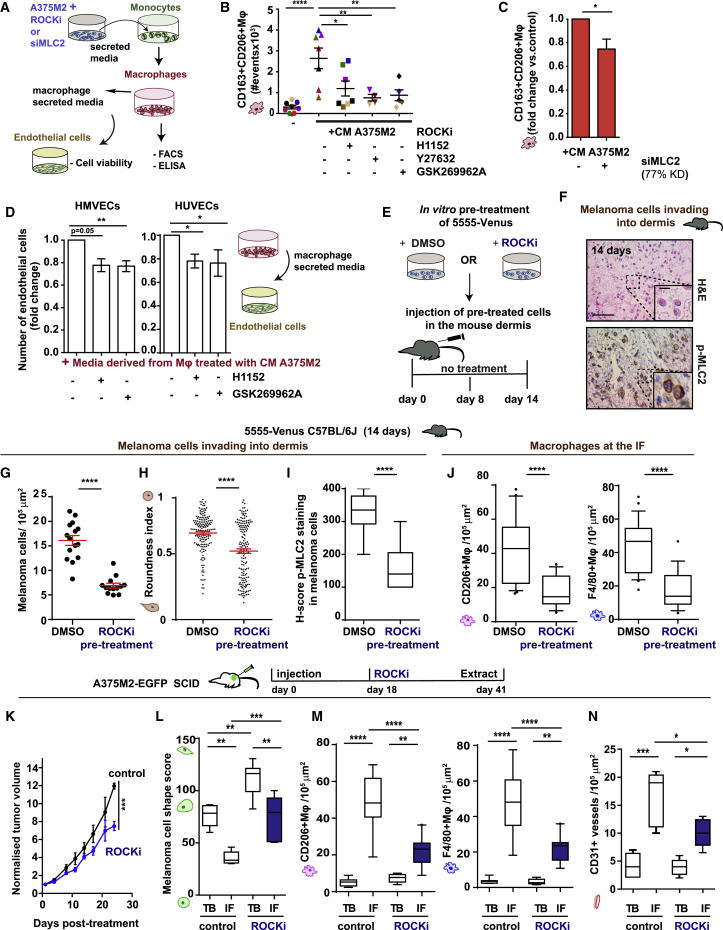
Blocking Myosin II Activity in Melanoma Cells Reprograms Macrophages(A) Schematic: in vitro treatment of PBMC-derived monocytes with CM from ROCK inhibited or MLC2 depleted A375M2 cells and subsequent assays.(B) CD163+CD206+ macrophages after treatment of PBMC-derived monocytes with CM A375M2, CM A375M2+ROCKi, or media only (–) (n = 8;8 different healthy donors; each dot is a different donor).(C) PBMC-derived monocytes treated with CM A375M2 depleted from MLC2 and quantification of CD163+CD206+ macrophages. Data are presented as fold changes versus control (n = 4).(D) Quantification of fold change of absorbance (O.D.): viability of endothelial cells (HMVECs and HUVECs) after treatment with macrophage-derived supernatants (50%). Media were derived from monocytes ± CM A375M2+ROCKi (n ≥ 3 for HMVECs and n = 6 for HUVECs). Endothelial cells were treated with macrophage-derived supernatants for 72 h.(E) Schematic: in vivo experiment with GSK269962A ROCKi pre-treated 5555 cells.(F) Representative H&E image (top) and IHC image for p-MLC2 showing amoeboid melanoma cells with high p-MLC2 invading the dermis in the IF of tumors 14 days post-intradermal injection of DMSO (vehicle) pre-treated 5555 cells. Scale bar, 50 μm; insert, 10 μm.(G–I) Number of invading melanoma cells (G), roundness index (H), and H-score (I) for p-MLC2 for (G).(J) (Left) CD206+ and (right) F4/80+ macrophages in the IF.(G–J) Tumors from DMSO (vehicle) pre-treated or ROCKi-pretreated Venus-5555 cells 14 days post-intradermal injection (n = 14 control and n = 12 ROCKi).(K) Tumor volume of A375M2 xenografts treated with PBS or Y27632 ROCKi.(L–N) Melanoma cell-shape score (L) and quantification (M) of (left) CD206+ and (right) F4/80+ and (N) CD31+ cells, in A375M2 xenografts treated with PBS or Y27632 ROCKi (n ≥ 4).In (B)–(D), (G), (H), and (K), graphs and dot blots show mean ± SEM. In (I), (J), and (L)–(N), boxplots show 10–90 percentile. In (B) and (L)–(N), one-way ANOVA with Tukey post hoc test is shown. In (C) and (G)–(J), t test is shown. In (D), Kruskal-Wallis test followed by Dunn’s multiple comparisons test is shown. In (K), two-way ANOVA with Bonferroni post hoc test is shown. Nonsignificant p > 0.05, ∗p < 0.05, ∗∗p < 0.01, ∗∗∗p < 0.001, ∗∗∗∗p < 0.0001.See also Figure S5.